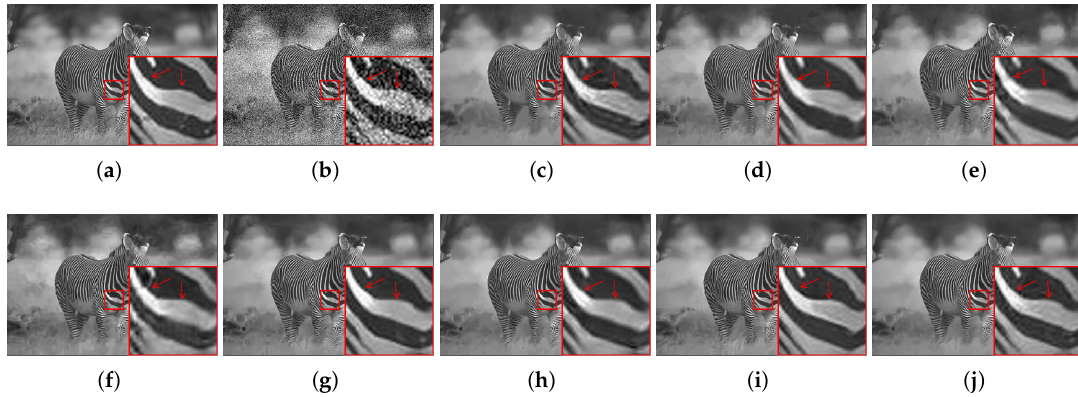
Figure 8. Comparison of denoising results of the competing methods for the test image with noise level σ = 40. ( a ) Original image. ( b ) Noisy image. ( c ) NCSR, PSNR = 26.73 dB. ( d ) WNNM, PSNR = 27.46 dB. ( e ) PGPD, PSNR = 27.03 dB. ( f ) BM3D, PSNR = 26.55 dB. ( g ) DnCNN, PSNR = 27.85 dB. ( h )